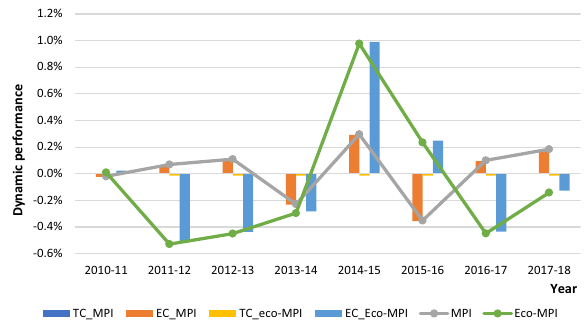
Fig. 2 In fl uence of ownership on productivity and eco- productivity change of Chilean water companies. Average estimates of productivity change (MPI) and eco-productivity change (eco-MPI) of Chilean water companies by ownership.